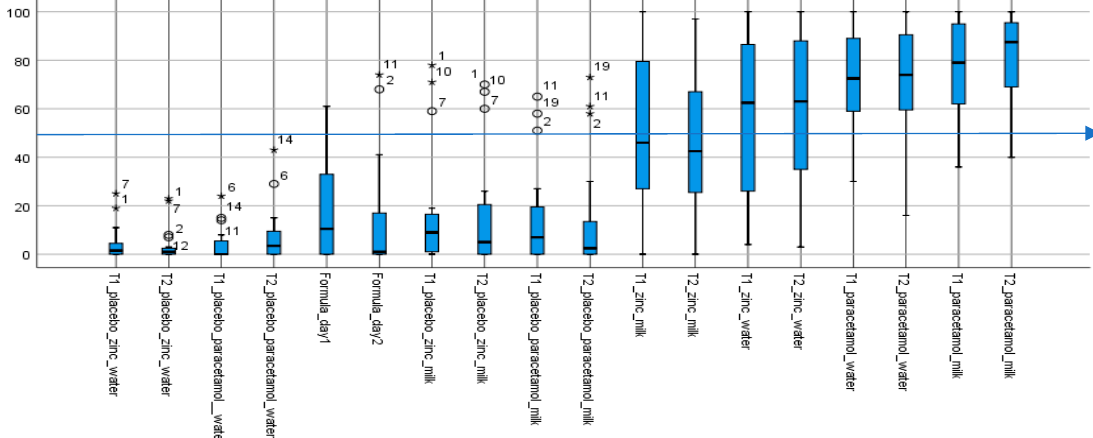
Figure 1. Summary of aversion scores for all 18 samples (except water). Aversion (taste) scores of test formulations. The box plots show the median taste score and ranges; outliers are indicated by the circles and extremes by the stars; with the numbers being volunteers’ de-identified IDs. (n = 18; as water score, assigned an anchored aversion of 0, on both days were excluded from the chart). T1 and T2, respectively lactose and mannitol, are the two different rapidly-disintegrating tablet platforms. All placebos, including infant formula milk (Formula_day1 and Formula_day2) with median scores below 50 (indicated by the blue line at 50) were not aversive. In contrast, with median taste scores above 50, all API-containing formulations were aversive, except for the two that contained zinc in infant formula milk. The paracetamol formulations, with interquartile ranges above 50 were the more aversive.